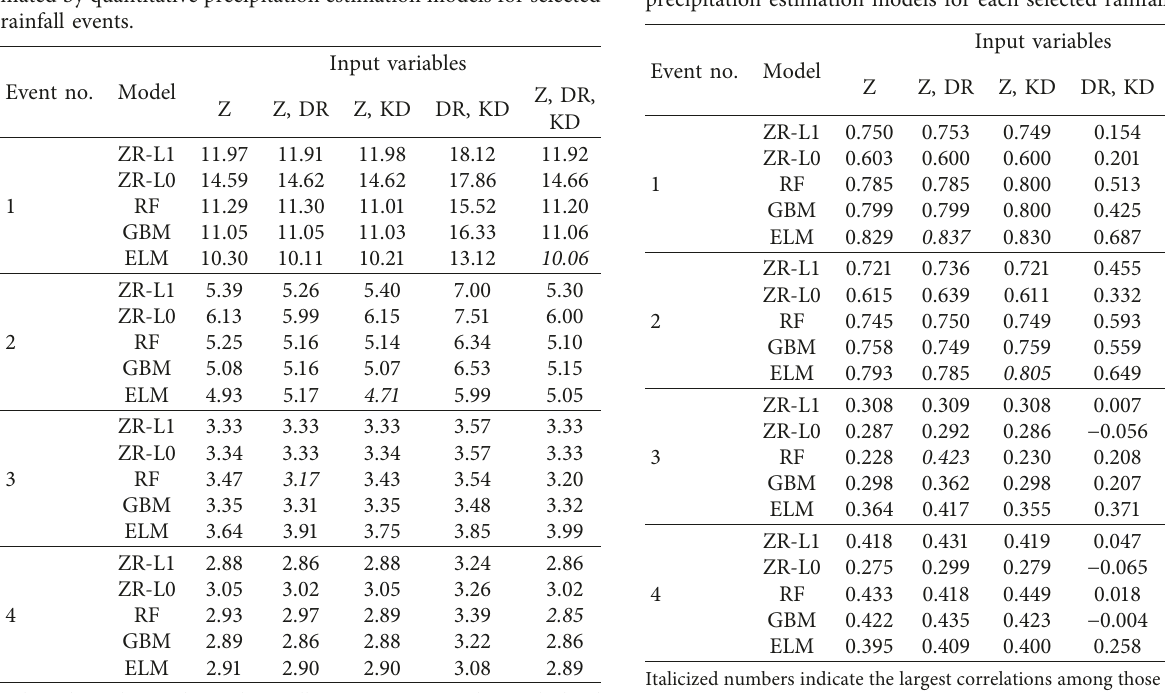
Table 5: Correlations of rain rate estimations by quantitative precipitation estimation models for each selected rainfall event.